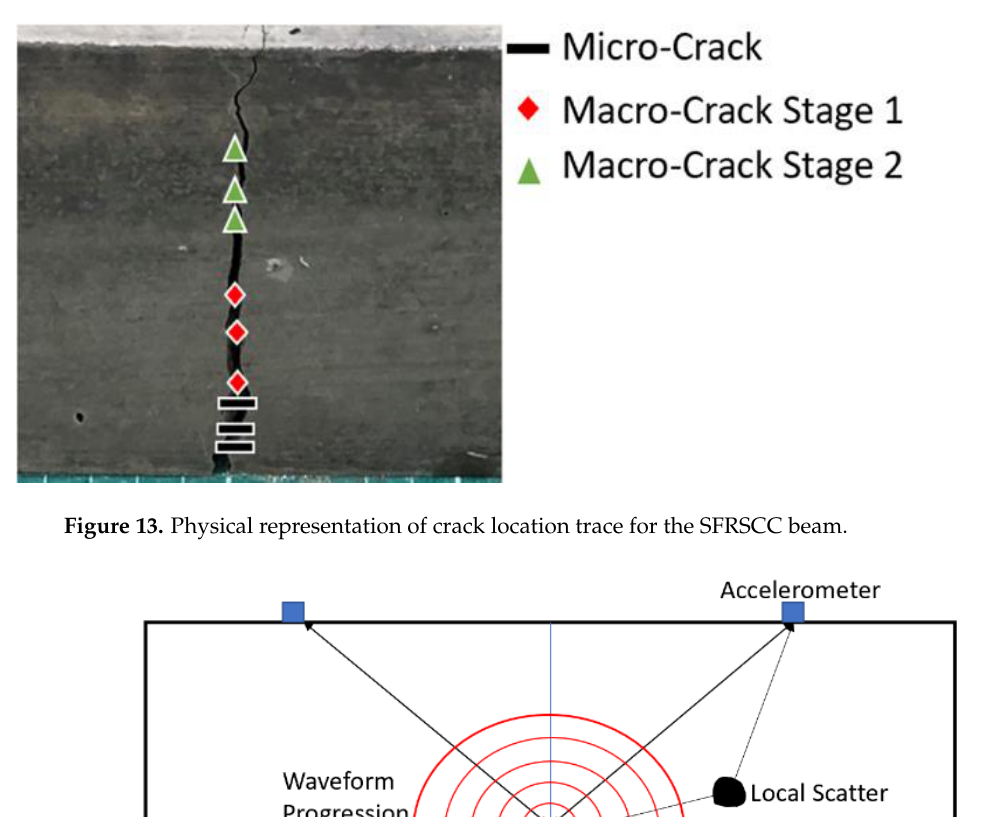
Figure 13. Physical representation of crack location trace for the SFRSCC beam.